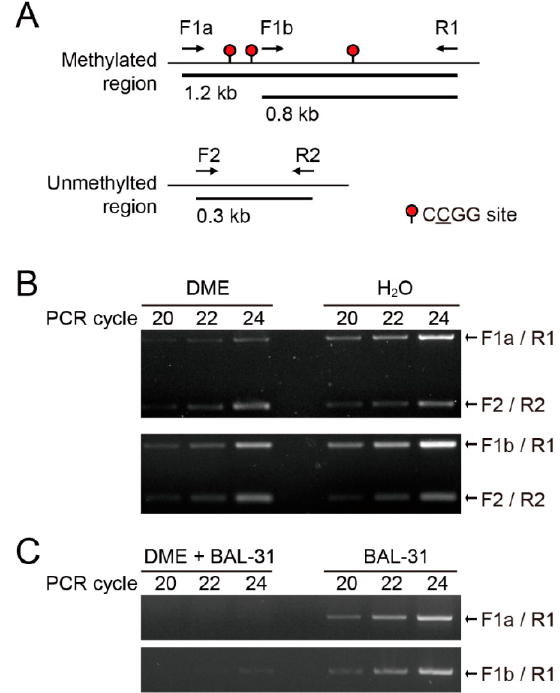
Figure 1. Quantitative analysis of DNA methylation by DEMETER (DME) treatment and PCR amplification. ( A ) Schematic diagrams of differentially methylated regions. Yeast genomic DNA was in vitro methylated with Hpa II methyltransferase for CCGG methylation. Methylated regions with a single or three CCGG sites were subjected to DME treatment and PCR amplification with F1a/R1 and F1b/R1 primer pairs, respectively. Unmethylated control region was amplified with F2/R2 primer pairs. ( B ) DME-induced SSBs decreases PCR amplification in proportion to DNA methylation levels. Hpa II-methylated yeast genomic DNA was treated with DME and subjected to multiplex PCR amplification. Primer pairs are denoted to the right of the panel. ( C ) DME and BAL-31 treatment induces DSBs at methylated regions. DSB formation by DME and BAL-31 treatment prevents PCR amplification regardless of the number of methylated sites.